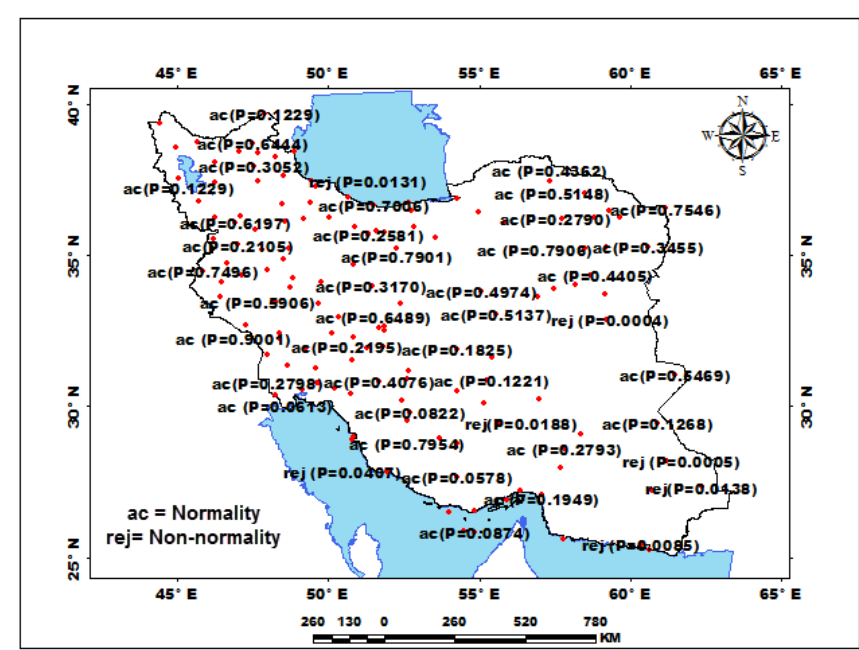
Figure 5. Results of D’Agostino-Pearson test for rainfall in Iran. Climate 2016 , 4 , x FOR PEER REVIEW